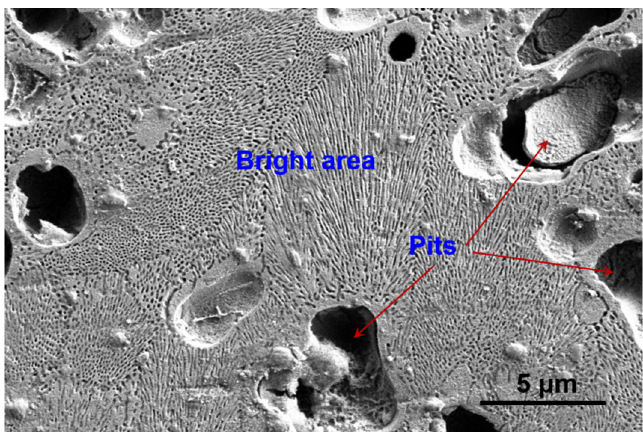
Figure 7. Typical microstructure of the seam cross-section.